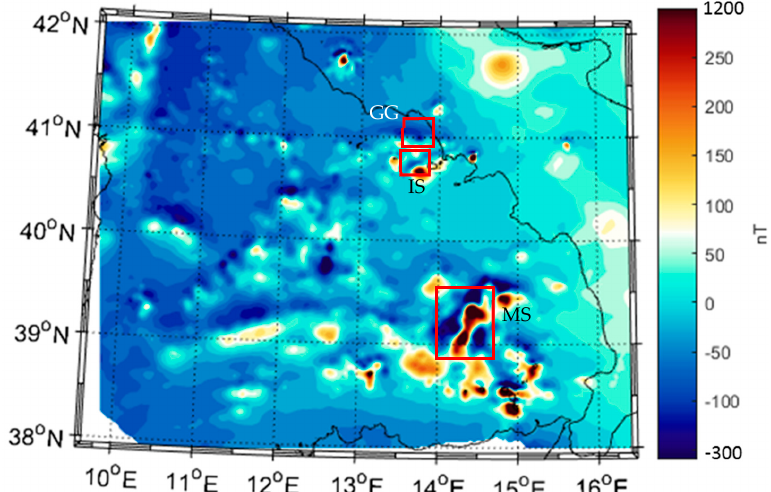
Figure 3. Total field aeromagnetic map of the Tyrrhenian Sea relative to the altitude of 1463 m above sea level. Red boxes marked IS, GG, and MS locate the areas analyzed in detail in Section 4.2 (W offshore of Ischia Island), Section 4.3 (Gaeta Gulf), and Section 4.4 (Marsili Seamount), respectively.